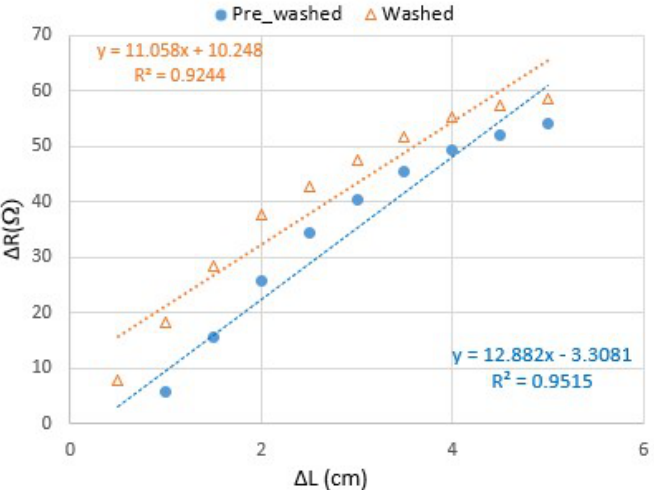
Figure 8. Elastic constant measurement before and after